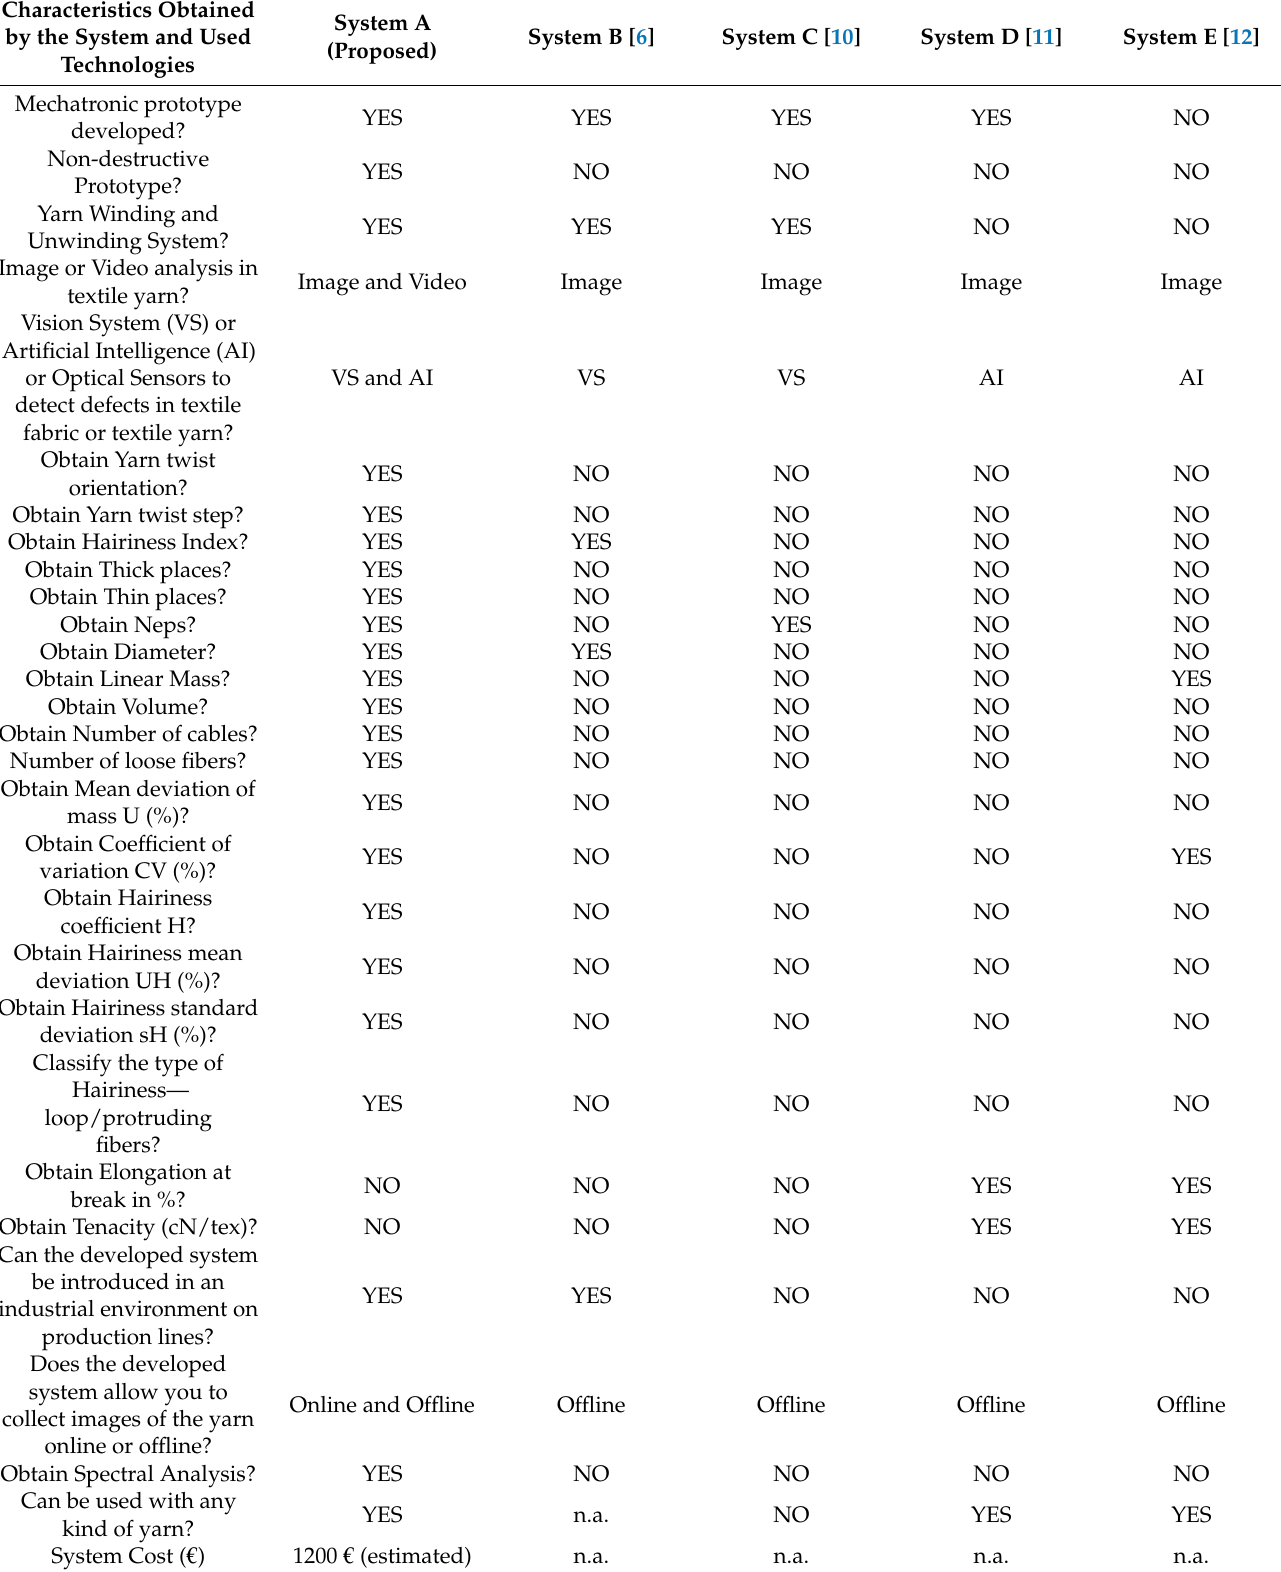
Table 1. Characteristics of the previously proposed solutions compared to the case